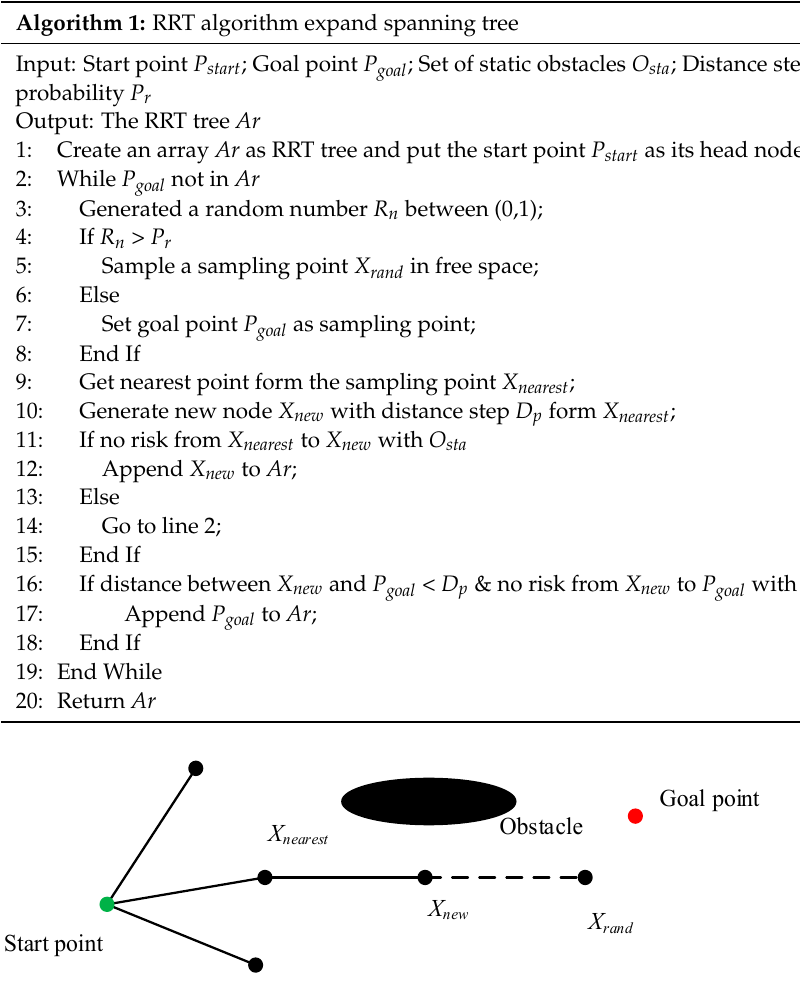
Algorithm 1: RRT algorithm expand spanning tree